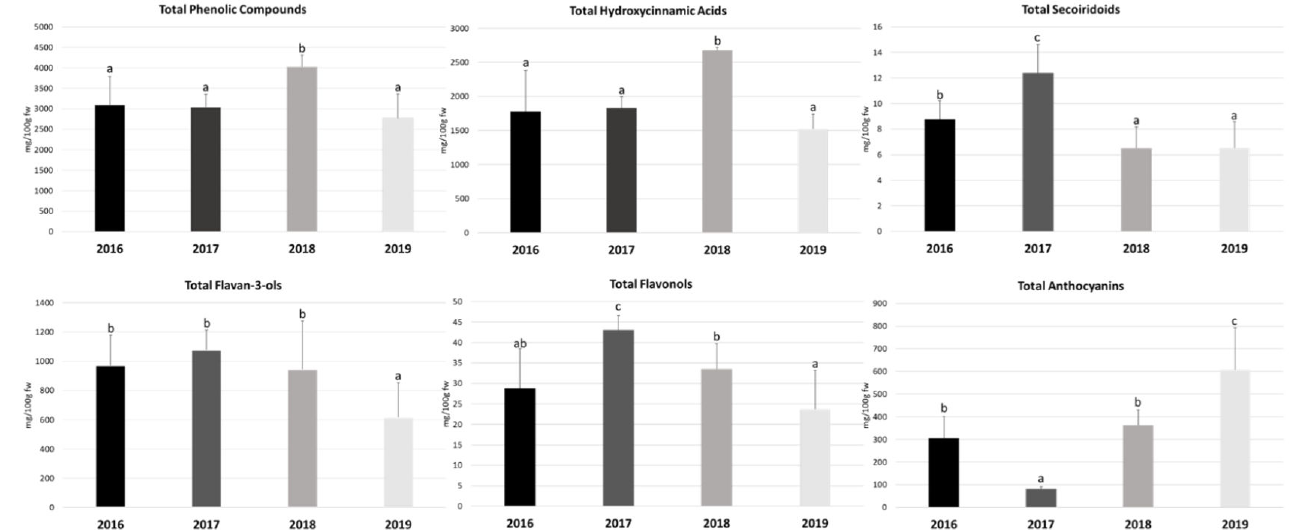
Figure 1. Data obtained as the sum of the concentrations of individual compounds within each class are shown as means ± SD ( n = 9). Bars with different letters within each bar plot are significantly different at p < 0.05 according to the one-way analysis of variance (ANOVA) and Tukey’s multiple range